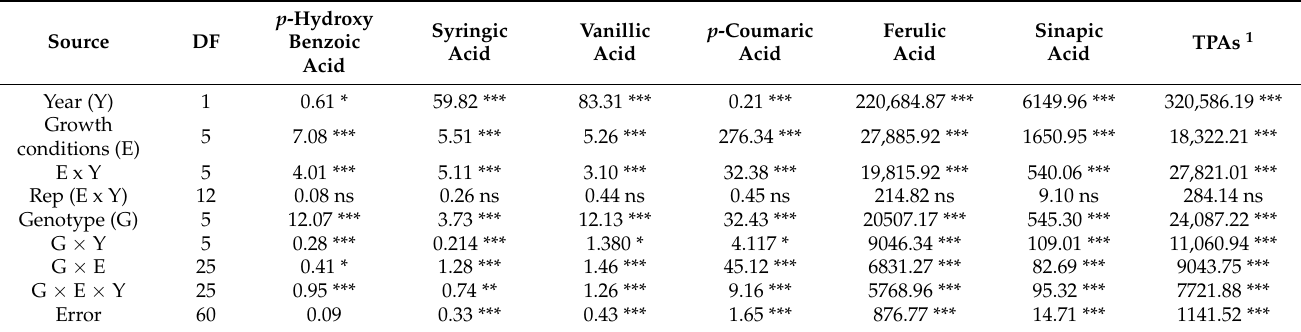
Table 2. Analysis of variance of individual phenolic acids in six CIMMYT durum wheat cultivars evaluated across two years and six growth conditions. Mean squares values are shown.